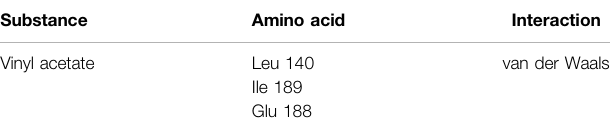
TABLE 4 | Amino acids and interactions type around the corresponding tunnel (tunnel 1) and ligand (vinyl acetate). Substance